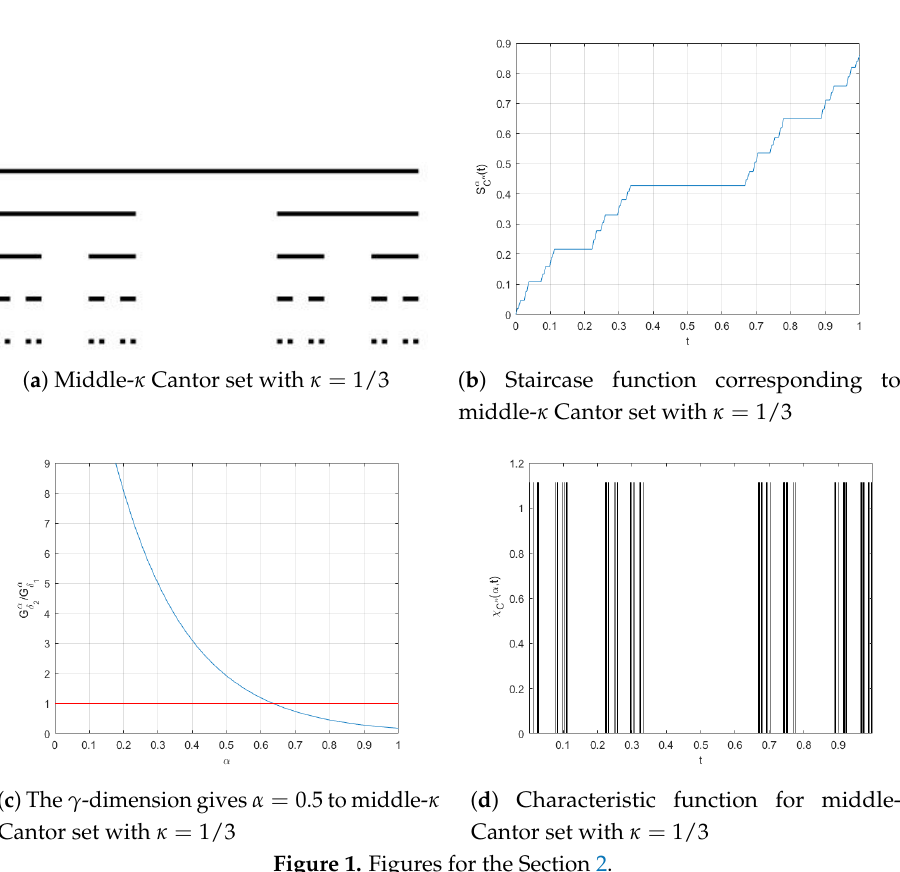
Figure 1. Figures for the Section